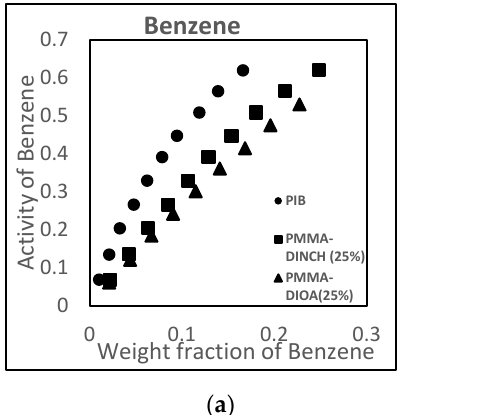
( b ) Figure 2. Frequency–time curves for pure PMMA-toluene ( a ) and a DINCH-plasticized PMMA system ( b ). Of the sensor films investigated in this work, PEMA plasticized with 5% DINCH or DIOA showed the maximum sorption and therefore the maximum response for all three analytes, benzene, toluene and ethylbenzene [25]. 3.2. Sensor Response Model Using the low-concentration QCM apparatus, the sensor response curves for the pure analytes benzene and toluene were collected and fit to Equation (6) to obtain the τ values and equilibrium frequency shifts for the identification of the analyte. For a PEMA-DIOA (10%) film, these values are shown in Table 5.